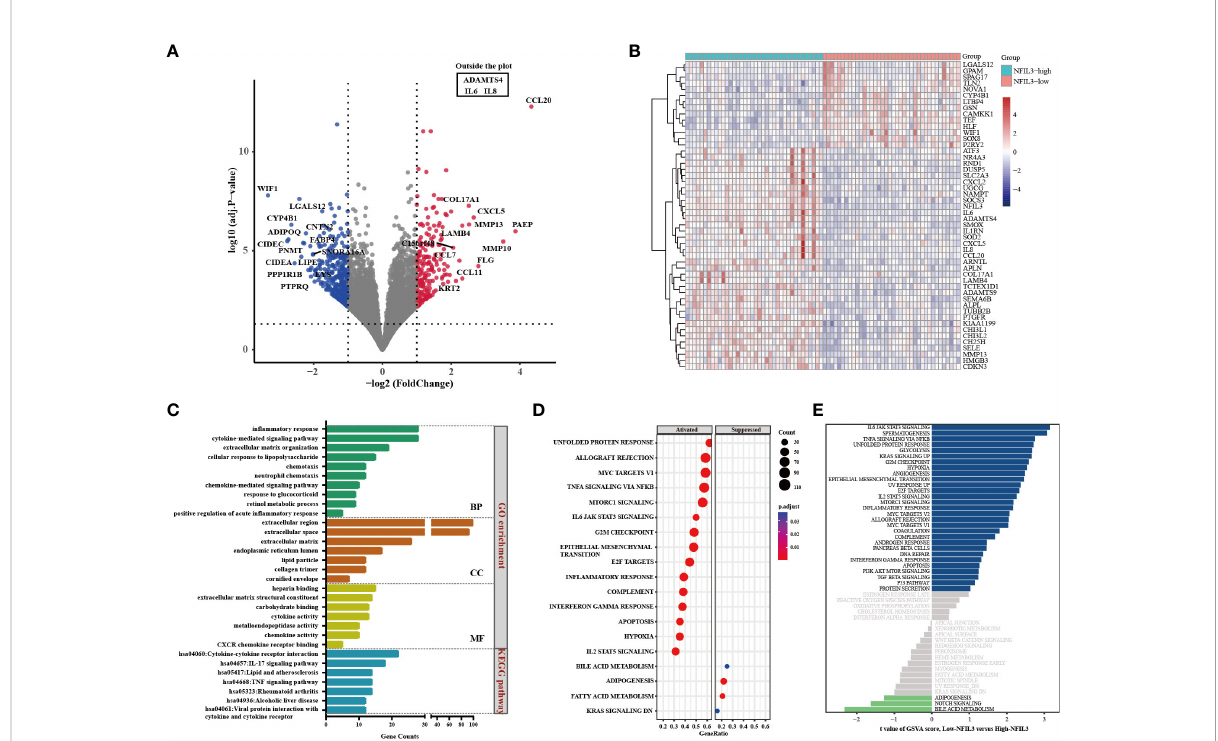
FIGURE 4 Identi fi cation of DEGs between the NFIL3-high and NFIL3-low groups and functional enrichment analysis. (A) Volcano plot shows the DEGs by comparing NFIL3-high and NFIL3-low synovial tissues from the GSE89408 dataset; red dot represents upregulated DEGs; blue dot represents downregulated DEGs; gray dot represents no signi fi cantly DEGs. (B) A heatmap of the 50 most signi fi cant DEGs according to the adjusted pvalue; blue indicates downregulated genes; red indicates upregulated genes. (C) GO enrichment and KEGG pathway analyses of the DEGs from DAVID database; the long bar represents the gene counts enriched in each pathway. (D) GSEA enrichment analysis shows that there are 15 upregulated and 4 downregulated gene sets with statistical signi fi cance between the high- and low-NFIL3 expression groups. (E) GSVA enrichment analysis of the 50 hallmark gene sets between the NFIL3-high and NFIL3-low groups. DEGs, differentially expressed genes; GSEA, gene set enrichment analysis; GSVA, gene set variation analysis. GO, Gene Ontology; KEGG, Kyoto Encyclopedia of Genes and